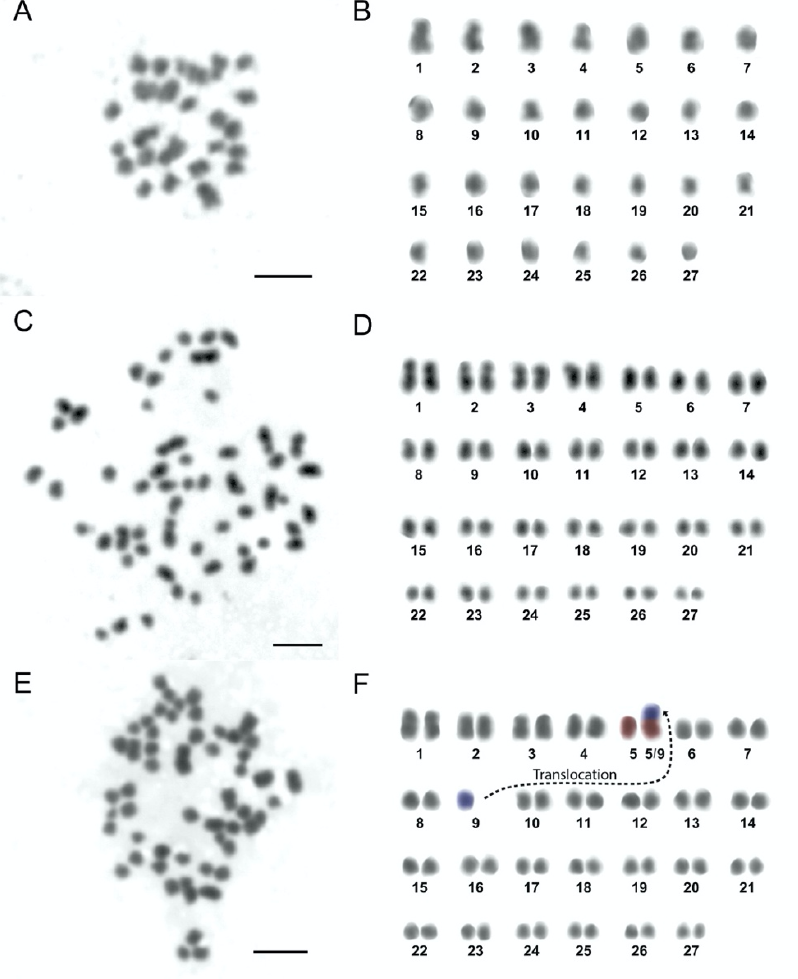
Figure 3: Karyotype analyses of Cataglyphis hispanica. (A,C and E) Metaphase chromosome slides of one haploid Chis2 male from Merida (A) and two F1 hybrid workers from Bonares (C) and Merida (E). (B,D and F) Corresponding karyotypes showing that the haploid chromosome number varies across populations. The male and the first worker display n=27 and 2n=27+27 chromosomes, respectively. By contrast, the second worker carries an unbalanced karyotype with 2n=26+27 chromosomes. The Robertsonian translocation hypothesized to be responsible for this polymorphism is indicated with dashed lines, and red and blue colors. The bar in all the images is 2